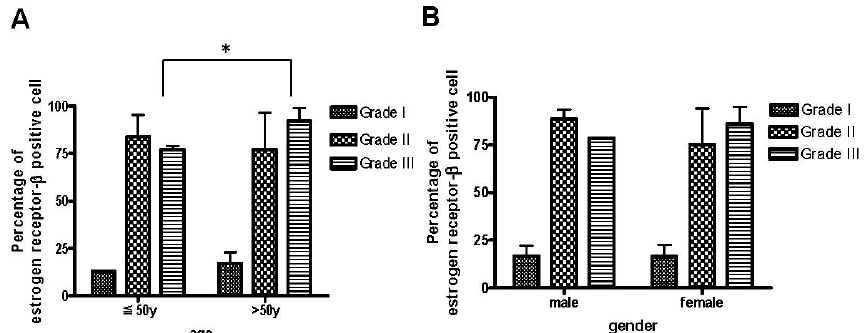
Figure 3. The percentage of ER- β -positive cells in the most severe tissue samples of de Quervain’s disease was age-dependent. ( A ) The expression of ER- β was higher in grade III area samples than in grade I and grade II area samples from patients >50 years old. The positive percentage was calculated as: (number of positive cells/total cells) × 100%. Data are mean ± standard deviation. * p < 0.05; and ( B ) No significant difference in the rate of expression of ER- β was found between men and women. Years(y): age.